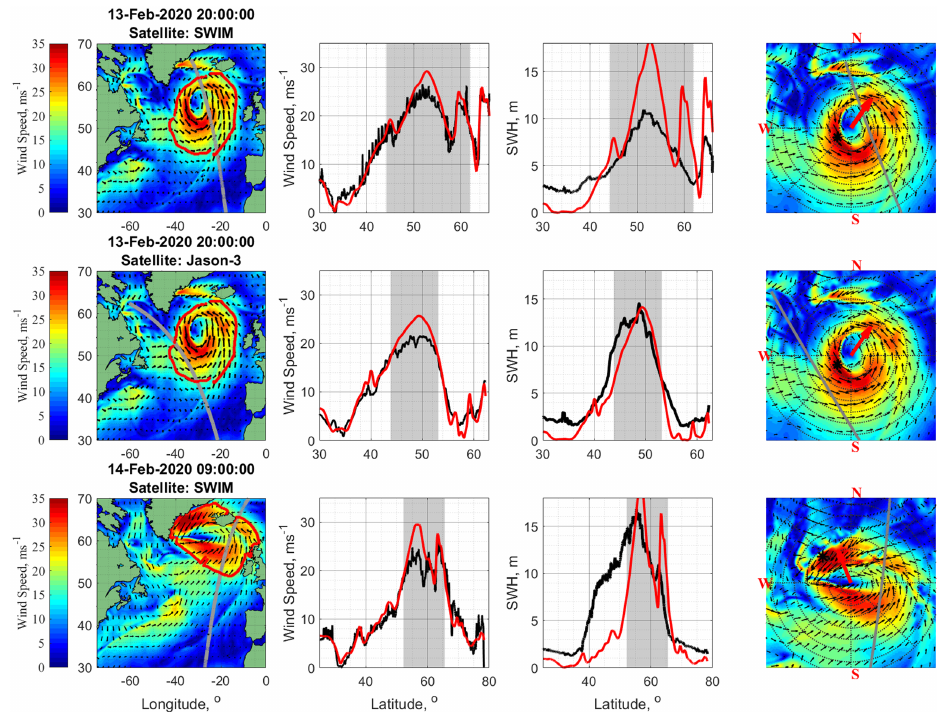
Figure 6. The same as in Figure 5, but for ETC#2 and altimeters AltiKa, CryoSat-2, Sentinel-3, Jason-3, and CFOSAT-SWIM nadir